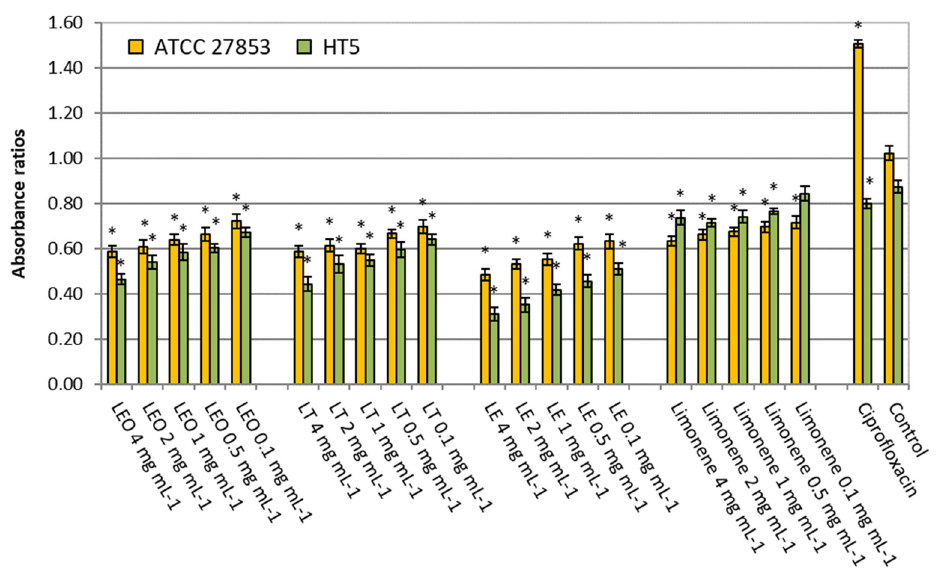
Figure 1. Specific biofilm formed by Pseudomonas aeruginosa strains without (control) and in the presence of ciprofloxacin (5 µg mL − 1 ) or different lemon oils concentrations (0.1–4 mg mL − 1 ). LEO: Lemon Essential Oil, LF: Lemon Terpenes, LE: Lemon Essence. Asterisk indicates significant differences compared to the respective control (Tukey’s multiple range test, p < 0.05).